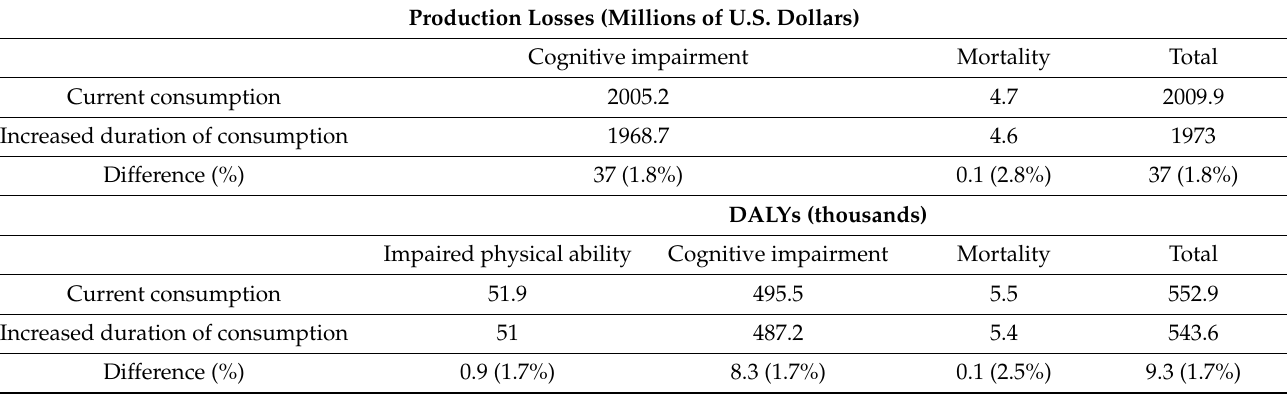
Table 3. Impact of increasing the duration of consumption of fortified infant cereals by 2 months on the burden of IDA in infants and young children with a short duration of consumption.